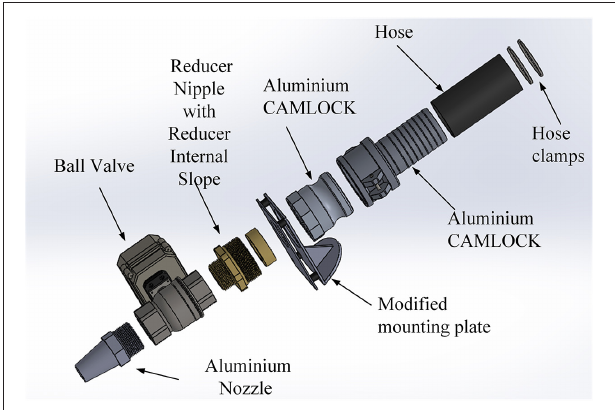
FIGURE 9 | Concept of extruder assembly in an exploded view that is connected to the progressive cavity pump and is attached to the end of the